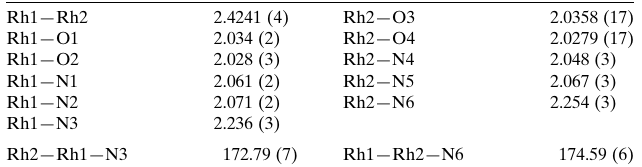
Selected geometric parameters (A˚ , (cid:3)